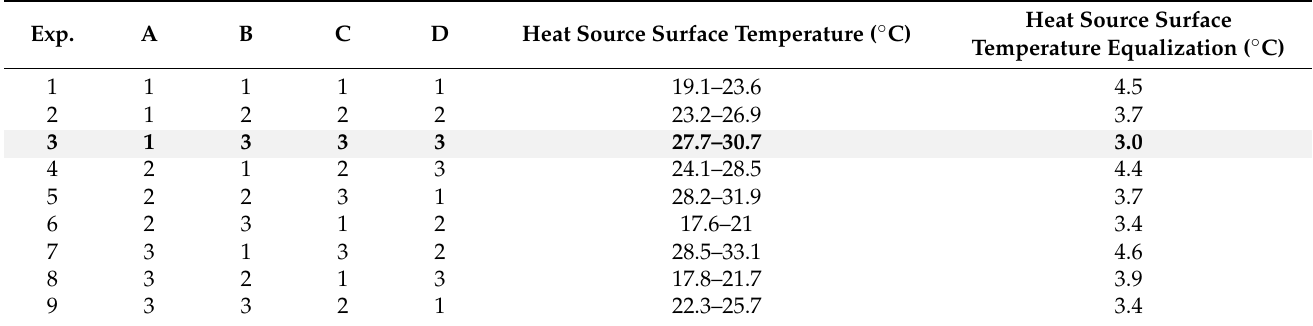
Table 4. Comparison of the heat dissipation performance of different design parameters (orthogonal arrays).